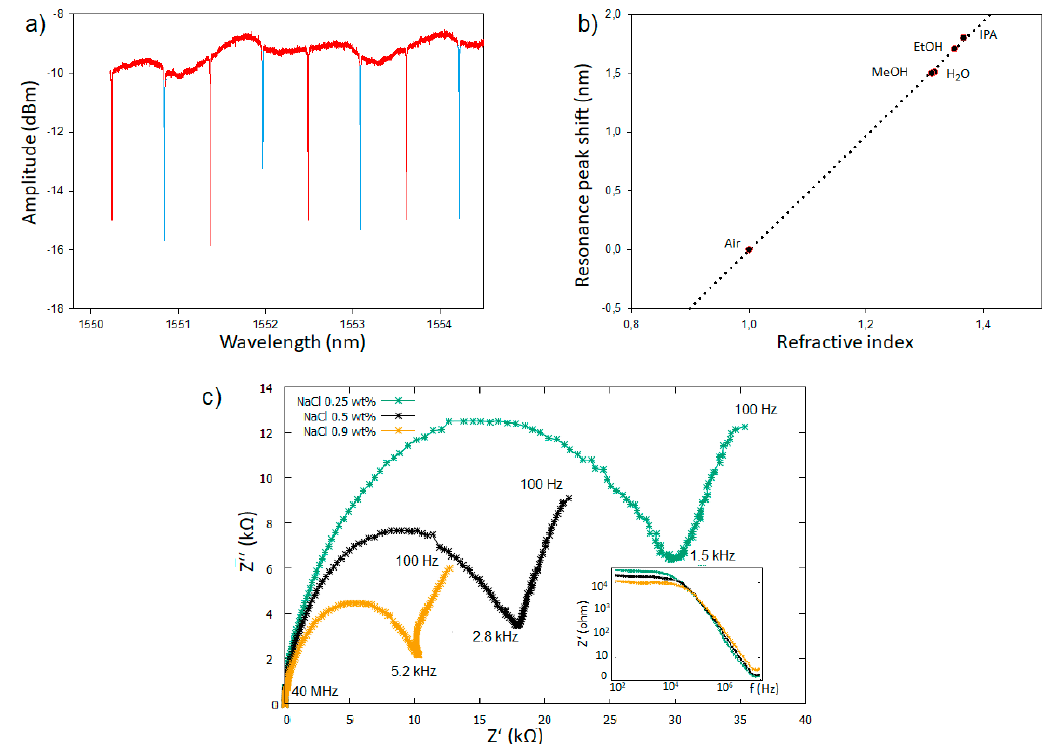
Figure 9. ( a ) A typical experimental transmission spectrum of the ring resonators. The red peaks are attributed to the reference ring and the blue to the sensor ring. ( b ) The resonance peak shift of the ring resonators exposed to MeOH (n = 1.3118), [51] H 2 O (n = 1.3164), EtOH (n = 1.3503), and isopropanol (n = 1.3661) normalized to the peak position in air (n = 1.003). [52] ( c ) Nyquist and Bode plot representing the impedance measurement of NaCl aqueous solutions, as performed with the coplanar electrode configuration.